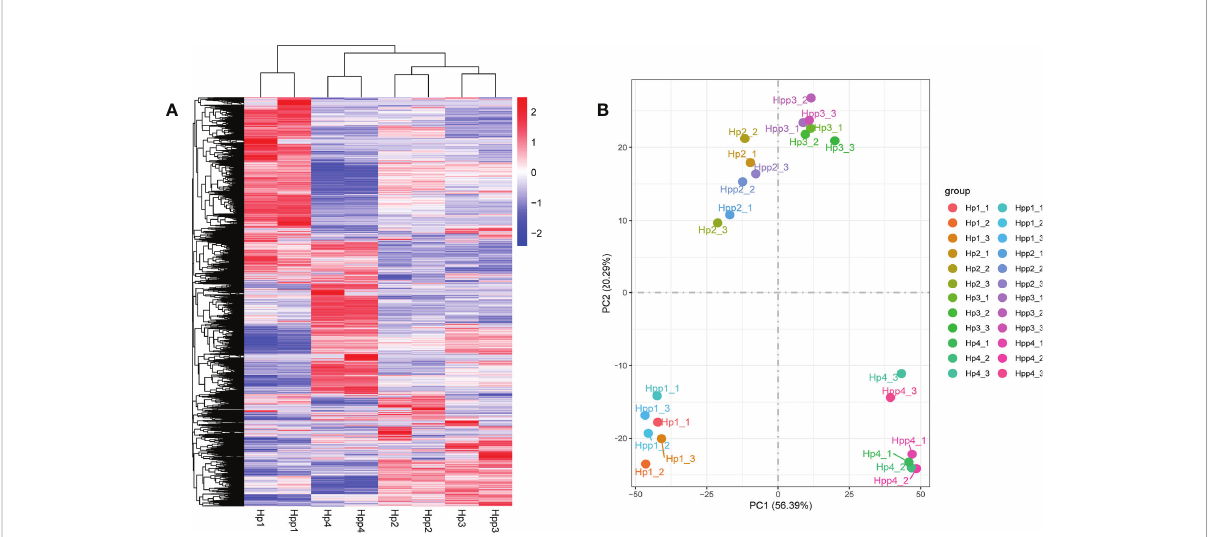
FIGURE 3 Clustering and Principal Component Analysis of Differential Metabolites between Harumi/Hongjv (HP) and Harumi/Ponkan/Hongjv (HPP) fruits. (A) Cluster heat map of differentially expressed genes (DEGs) between different samples, where red represents upregulation and blue represents downregulation. (B) Principal component analysis of the Harumi/Hongjv (HP) and Harumi/Ponkan/Hongjv (HPP) groups at 45, 90, 135, and 180 days after fl owering (DAF). HP1, HP2, HP3 and HP4 represent HP at 45, 90, 135, and 180 DAF, respectively; and HPP1, HPP2, HPP3 and HPP4 represent HPP at 45, 90, 135, and 180 DAF, respectively. Each value shown represents the mean of three biological